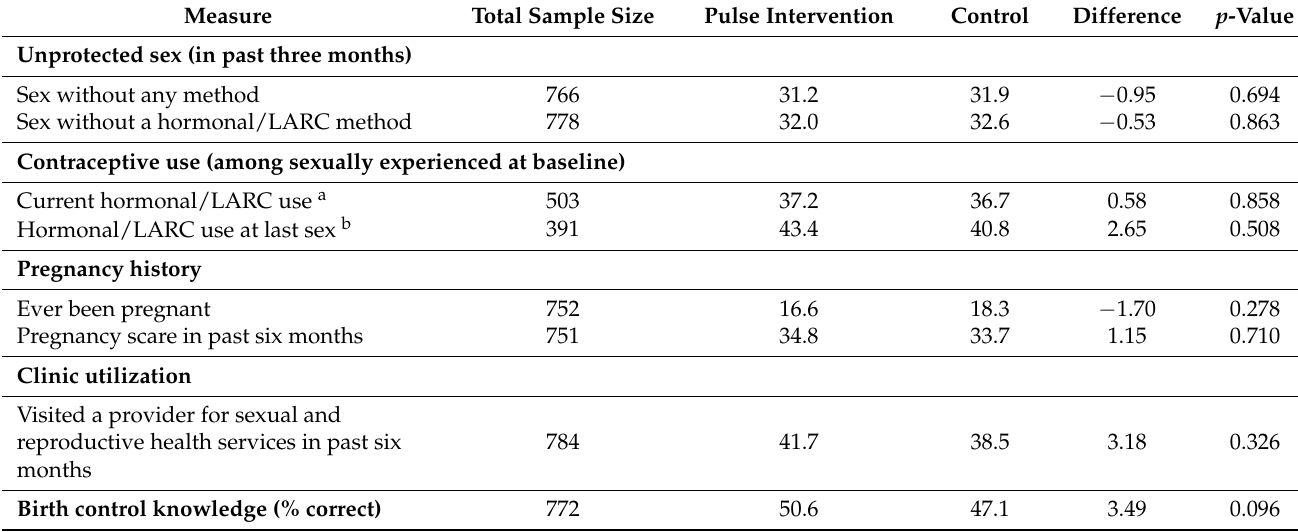
Table 4. Impacts on primary and secondary outcomes at six-month follow-up, for current replication study. Measure Total Sample Size Pulse Intervention Control Difference p